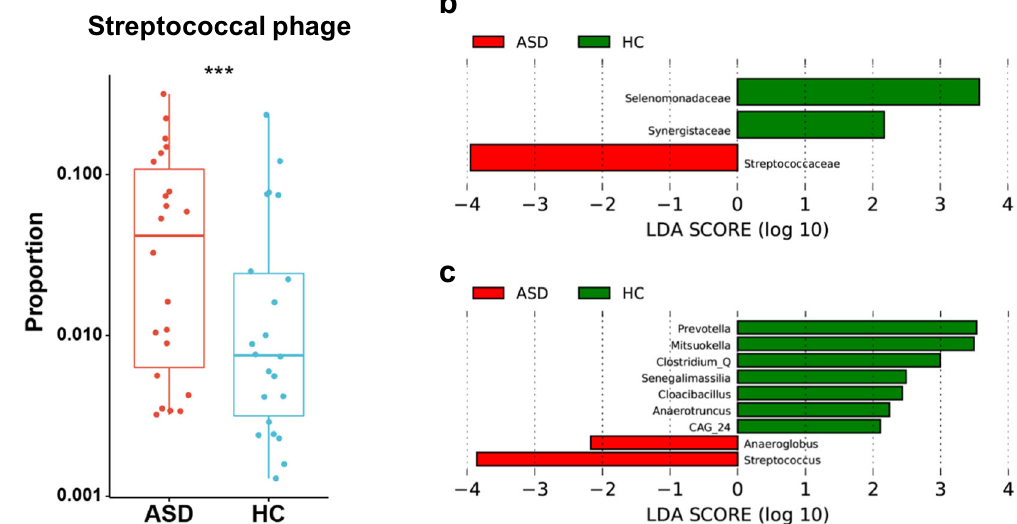
Fig. 4 Enrichment of Streptococcal phages in the oral microbiota of ASD subjects. a The difference between ASD and HC subjects in their Streptococcal phage proportion in the oral phage communities, tested by the Wilcoxon signed-rank test for the quasi-paired cohort with FDR < 0.001(***). In box-whisker plots, the middle horizontal line refers to the median value, and the width of the box is the interquartile range (IQR) with 1.5 IQR whisker length. b , c LEfSe analysis is based on the relative abundance of phage groups hosted by each family ( b ) and genus ( c ) level in the oral. Only groups of effect size >2 and p < 0.05 (Kruskal – Wallis test) are presented with red and green bars indicating the effective size of phage groups as pro-ASD and pro-HC samples,